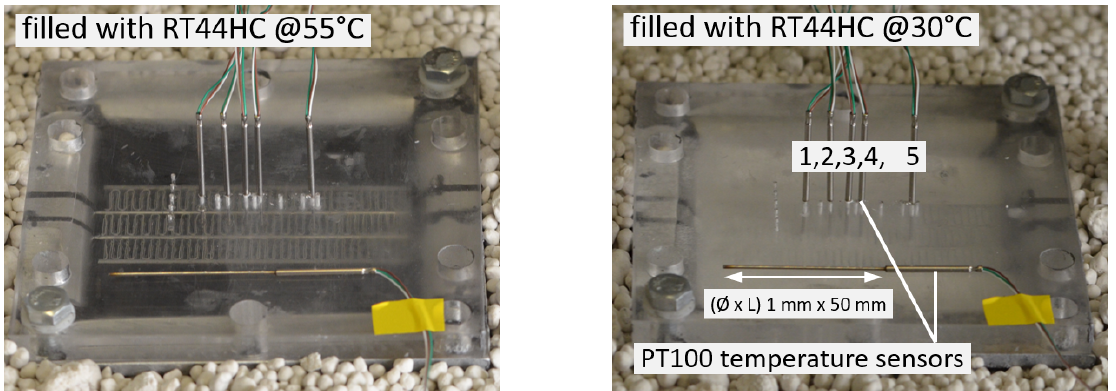
Figure 8. Experimental tests with the thermally insulted HEX. The top plate is made from acryl